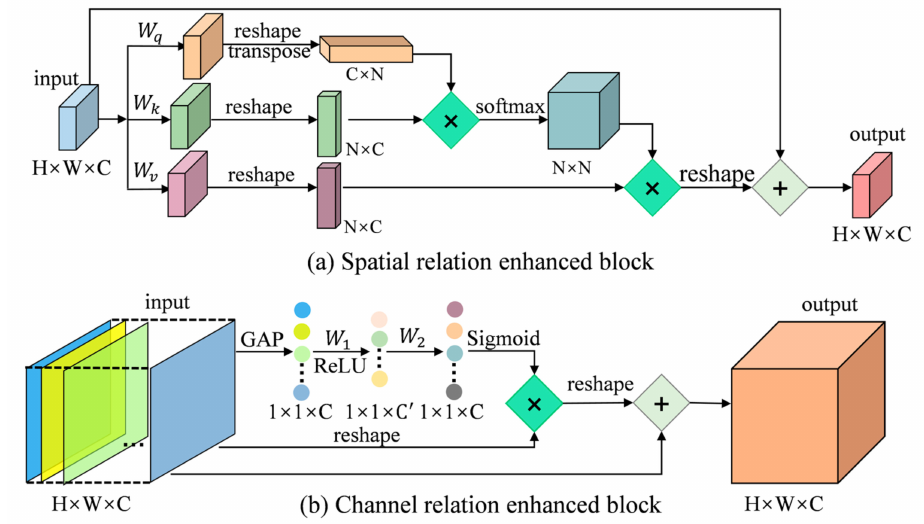
Figure 3. The basic principle chart of relation-enhanced blocks. ( a ) Spatial relation-enhanced block; ( b ) channel relation-enhanced